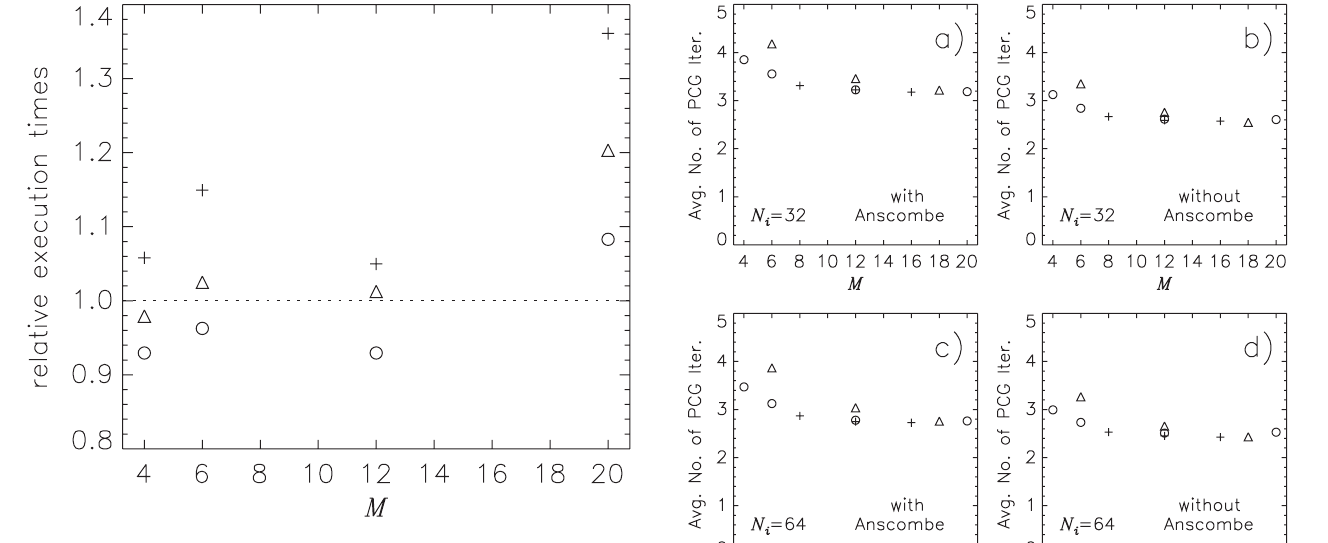
FIG. 17. Comparison of relative execution times of IMPACT-T with PCG vs standard FFT-based IMPACT-T for the full simulation for Distribution 1 with 30 000 steps, N (cid:4) 125 000 particles and (cid:4) 32 . Speed of the standard IMPACT-T is repre- resolution N i sented by unity. Circles represent PCG with no thresholding, crosses PCG with Anscombe transformation and thresholding, and triangles PCG with thresholding and no Anscombe trans- formation. M (cid:4) 4 represents Daubechies wavelet family of order 2, M (cid:4) 6 Daubechies family of order 3, M (cid:4) 12 Daubechies family of order 6, M (cid:4) 20 Daubechies family of order 10. This figure illustrates only the numerical speed of the new method when compared to the FFT-based method with all parameters of the simulation and the number of macroparticles being equal. The substantial computational savings come from the IMPACT-T simulation with a wavelet-based Poisson solver requiring fewer macroparticles than the FFT-based IMPACT-T for comparable quality results (see text and Figs. 15 and 16).